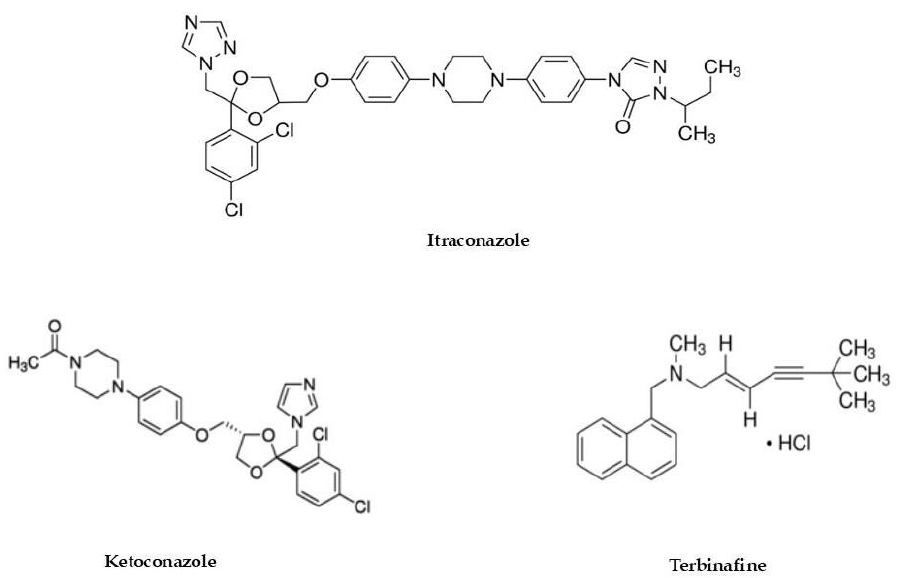
Figure 1. Chemical structures of azoles (itraconazole, ketoconazole) and terbinafine. The preferred treatment for cutaneous infections caused by Trichophyton spp.